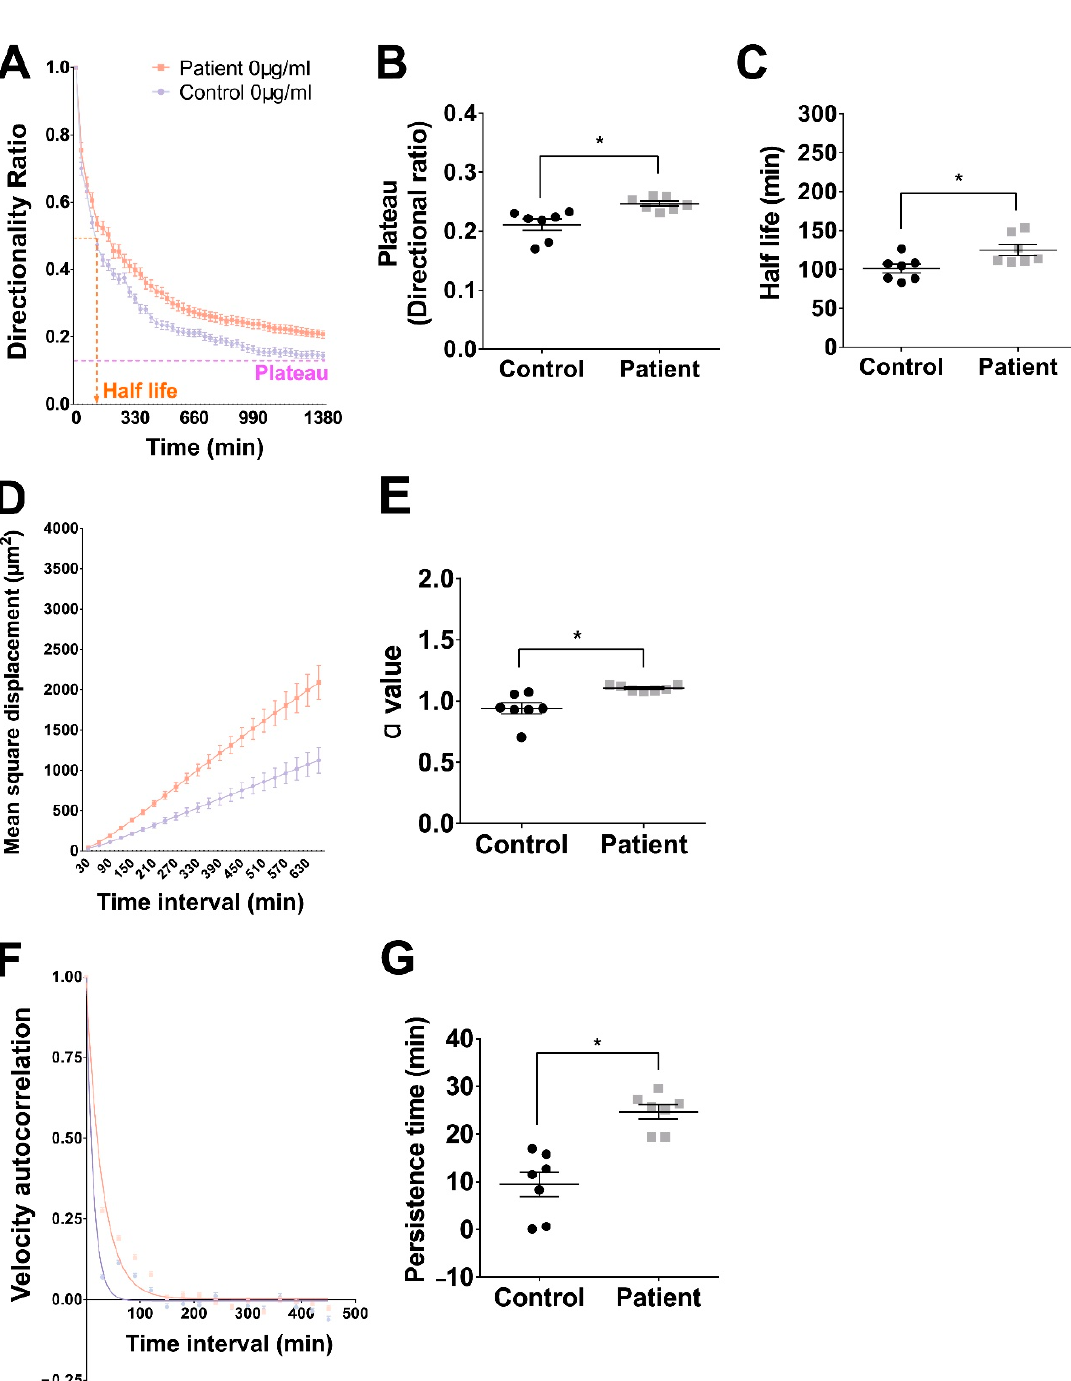
Figure 1. Patient cells were more persistent than control cells on uncoated tissue culture plastic. ( A ): Directionality ratio calculated for patient cells (red) and control cells (blue). Mean ± SEM at each time point. Indications of Plateau and Half-life are shown. ( B ): Plateau values for patient and control cells. Symbols represent means of all cells for individuals in each group. Bars represent mean ± SEM for each group. ( C ): Half-life values for patient and control cells. Symbols represent means of all cells for individuals in each group. Bars represent mean ± SEM for each group. ( D ): Mean Square Displacement calculated for patient cells (red) and control cells (blue). Mean ± SEM at each time point. ( E ): MSD α -values for patient and control cells. Symbols represent means of all cells for individuals in each group. Bars represent mean ± SEM for each group. ( F ): Velocity autocorrelation calculated for patient cells (red) and control cells (blue). Mean ± SEM at each time point. ( G ): Persistence times (inverse of decay rate of velocity autocorrelation) for patient and control cells. Symbols represent means of all cells for individuals in each group. Bars represent mean ± SEM for each group. * = p < 0.05, t